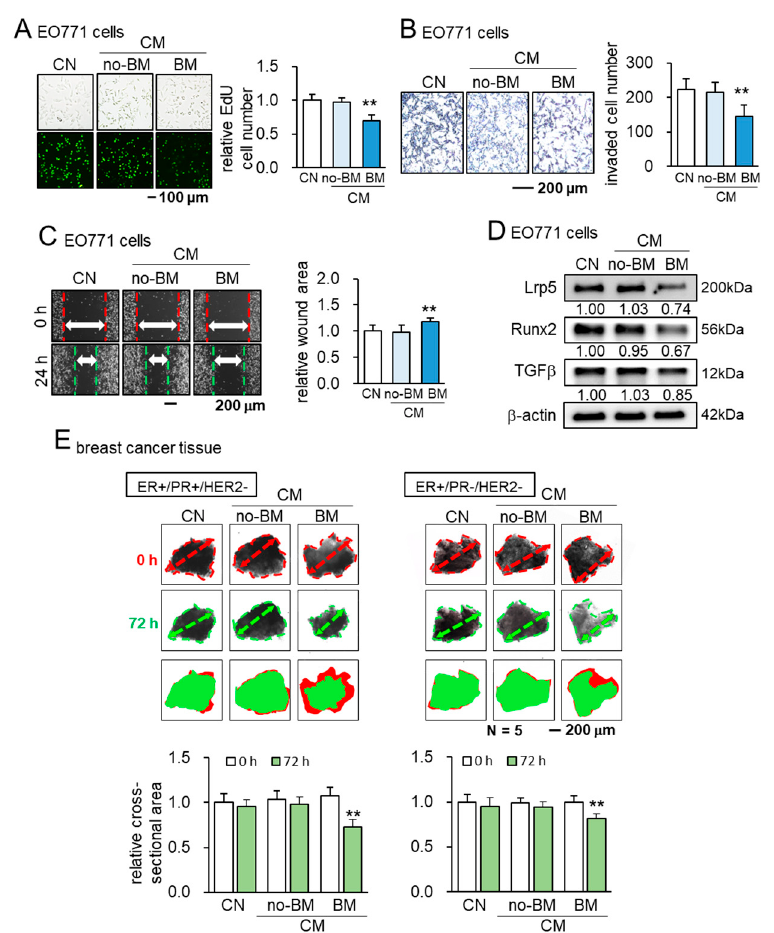
Figure 3. Tumor-suppressive effects of BM CM. CN = control, CM = RAW264.7 osteoclasts-derived conditioned medium, no-BM = treated without BML284, BM = BML284 treated. ** p < 0.01. ( A – C ) Suppression of EdU-based proliferation, transwell invasion, and scratch-based migration of EO771 tumor cells by BM CM. ( D ) Downregulation of Lrp5, Runx2, and TGF β in EO771 tumor cells by BM CM. ( E ) Shrinkage of human breast-cancer-tissue fragments by BM CM for 3 days.